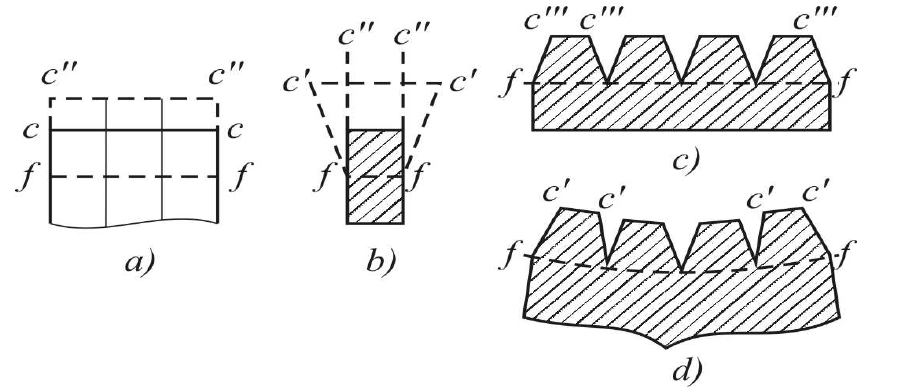
Figure 4 – Scheme of cracks formation in the surface layer of the